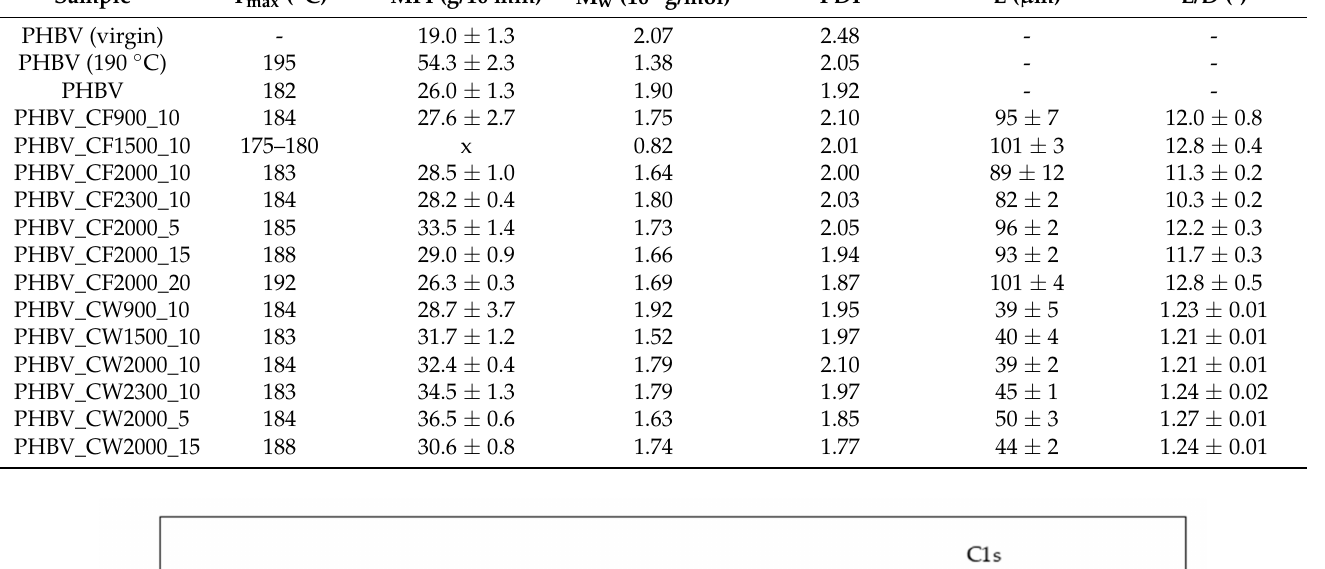
Table 3. Maximum mass temperature during mixing, MFI (190 ◦ C/2.16 kg) of prepared compounds, weight average molecular mass and polydispersity index of PHBV after mixing and filler dimensions after injection molding.